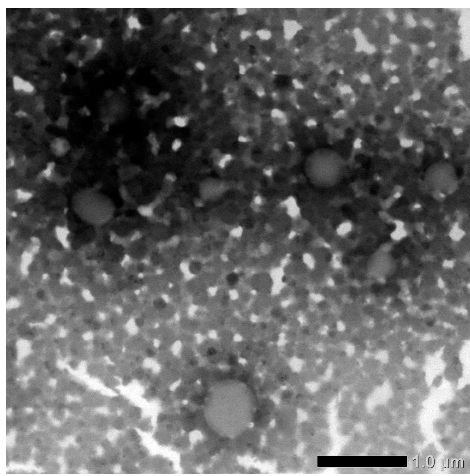
Figure 7. The TEM image of colloidal Ag nanoparticles after addition of the complex of Pb(II)- dithizone.